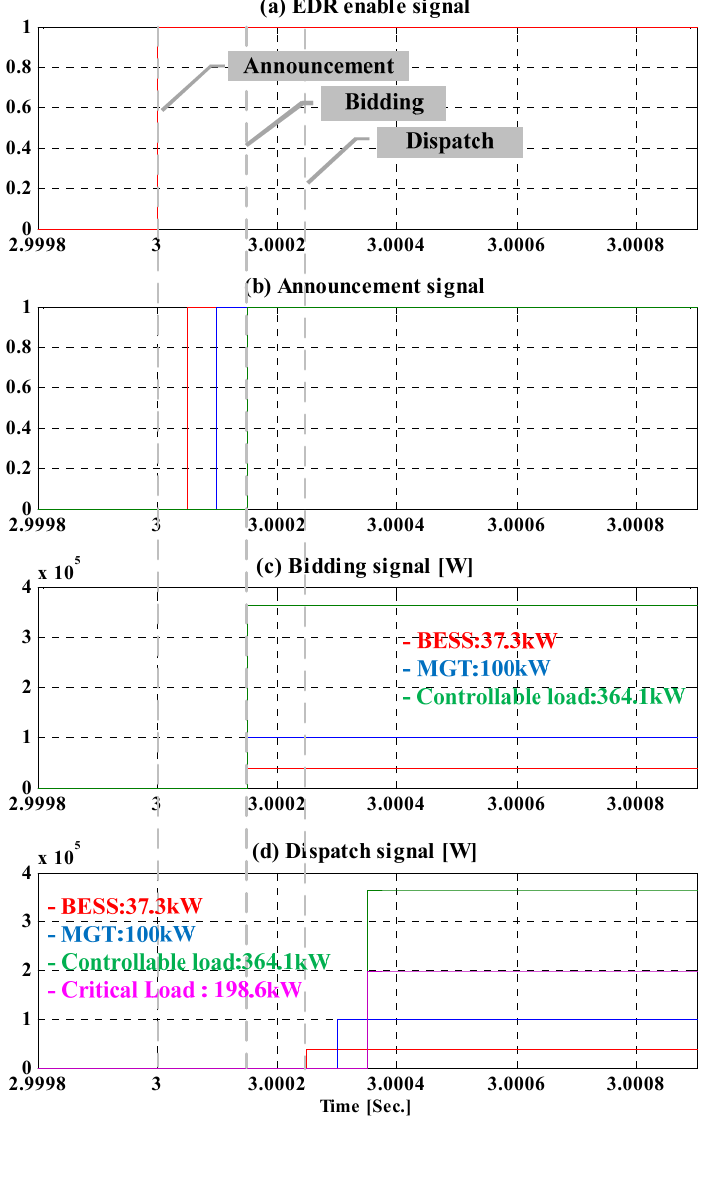
Figure 18. Decision making procedure for EDR power dispatch in case